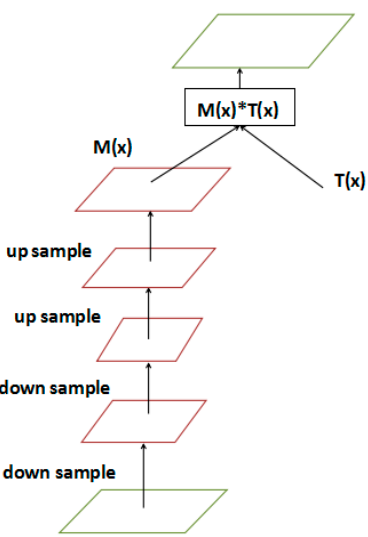
Figure 6. The architecture of the mask branch. The mask branch contains two steps: Feed-forward sweep and top-down feedback. The two steps behave as a bottom-up top-down fully convolutional structure.